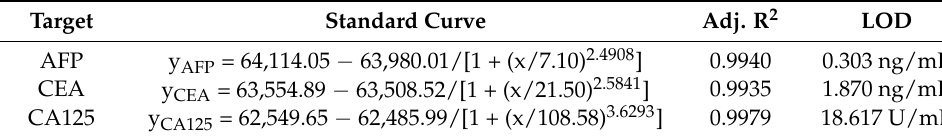
Table 1. Standard curves and the limits of detection